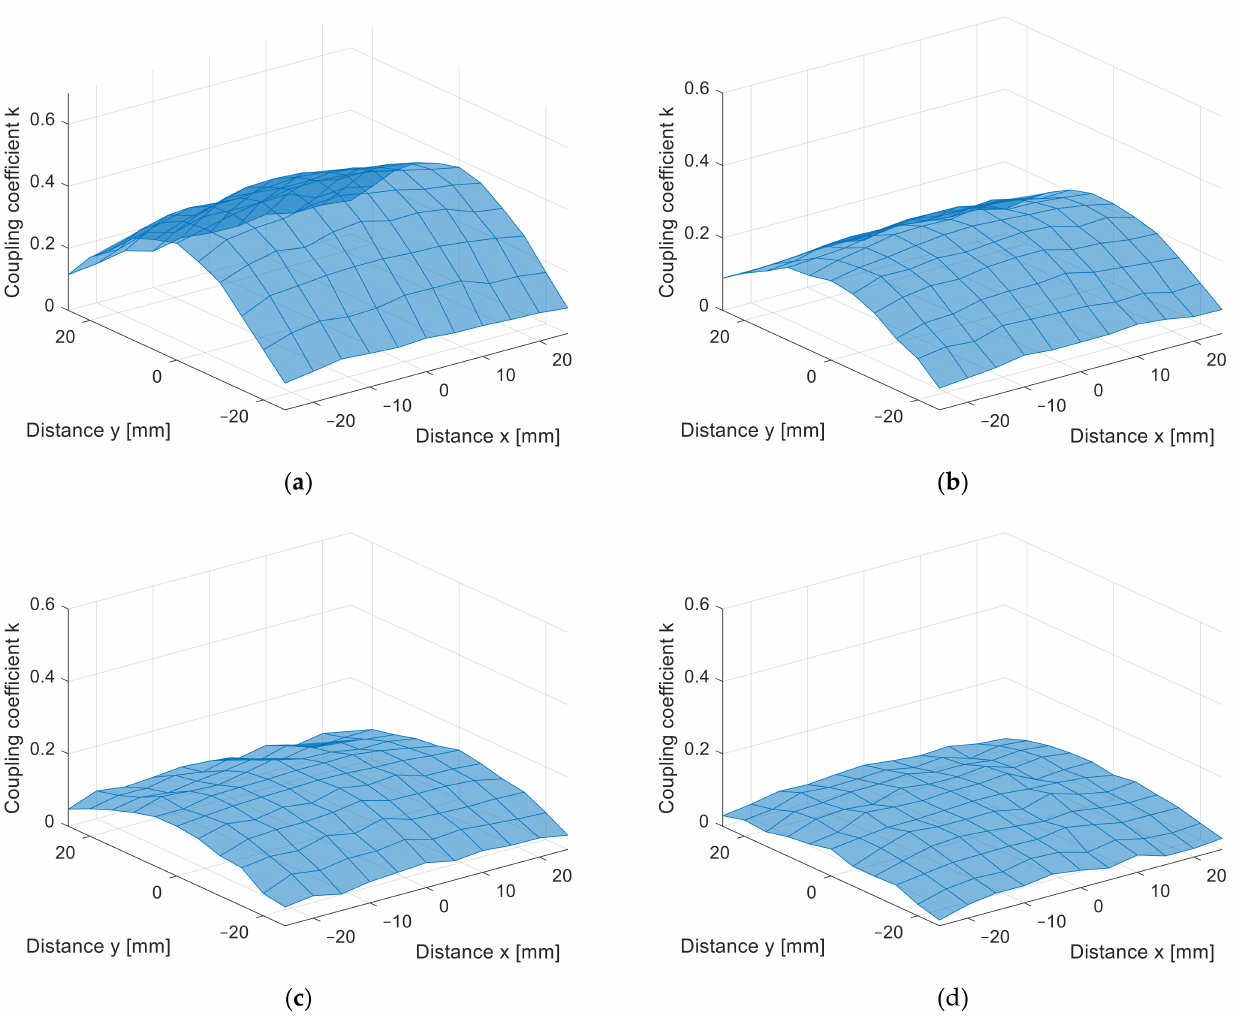
Figure 14. x - y coupling coefficient measurement of planar DD coils (3D surface plot). ( a ) At z = 10 mm, ( b ) at z = 15 mm, ( c ) at z = 20 mm, ( d ) at z = 25